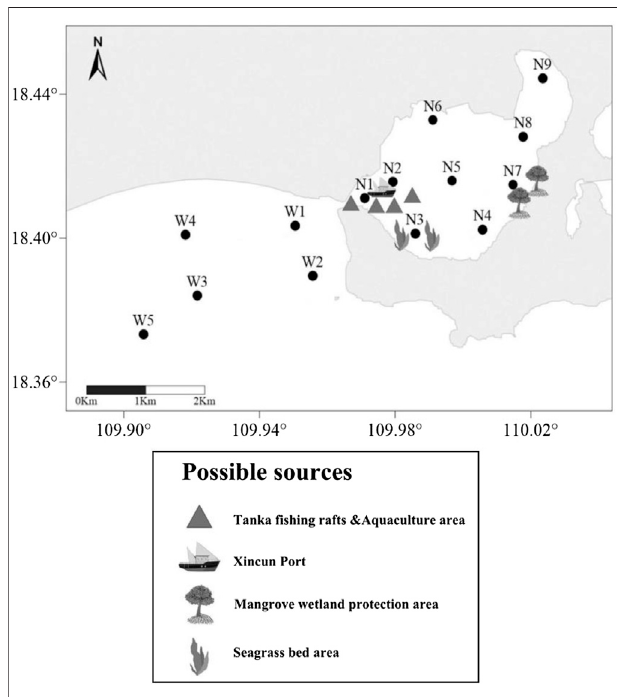
FIGURE 1 | Map showing the study area around Xincun Bay. The black dots are the surface water and sediment sampling stations. N and W represent the sampling stations inside and outside Xincun Bay,